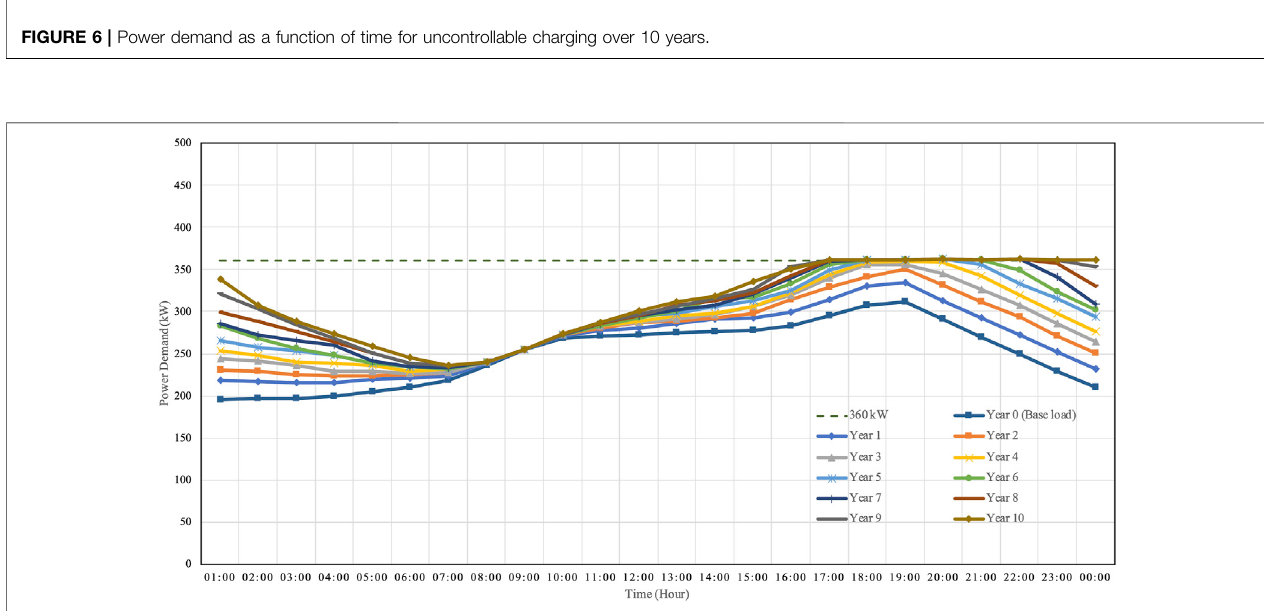
FIGURE 7 | Power demand as a function of time for smart charging with direct control over 10 years.